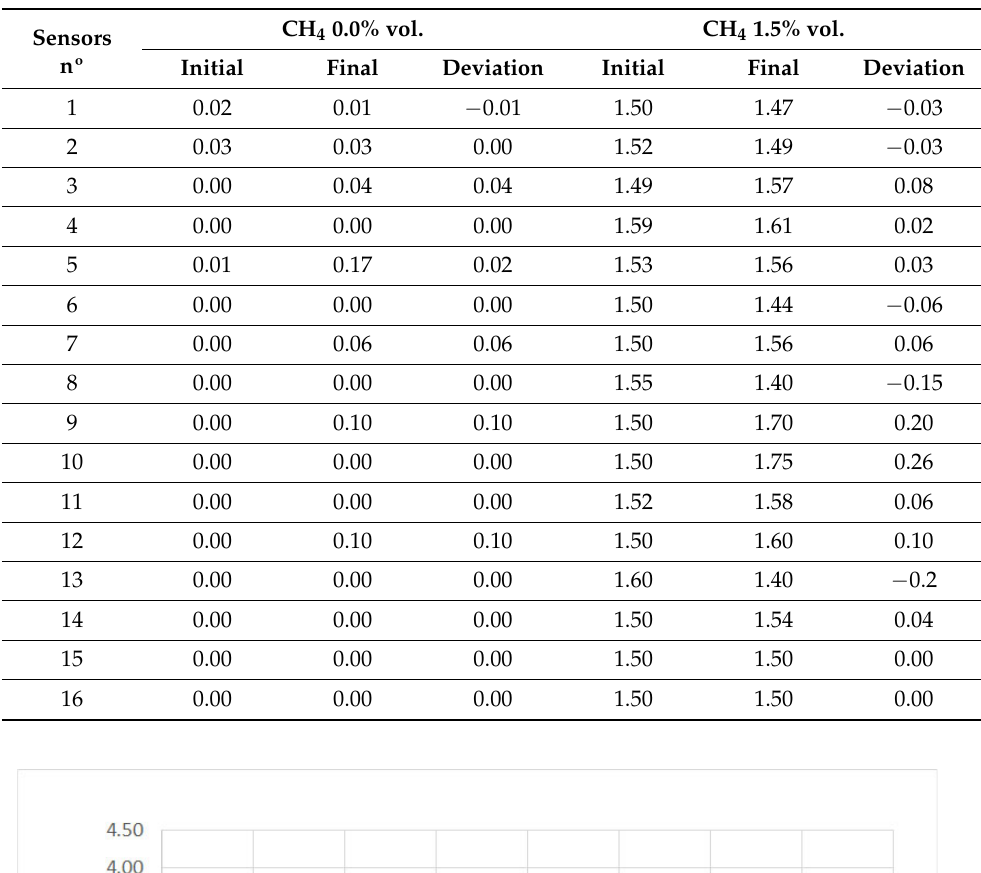
Table 7. Residual effect results.